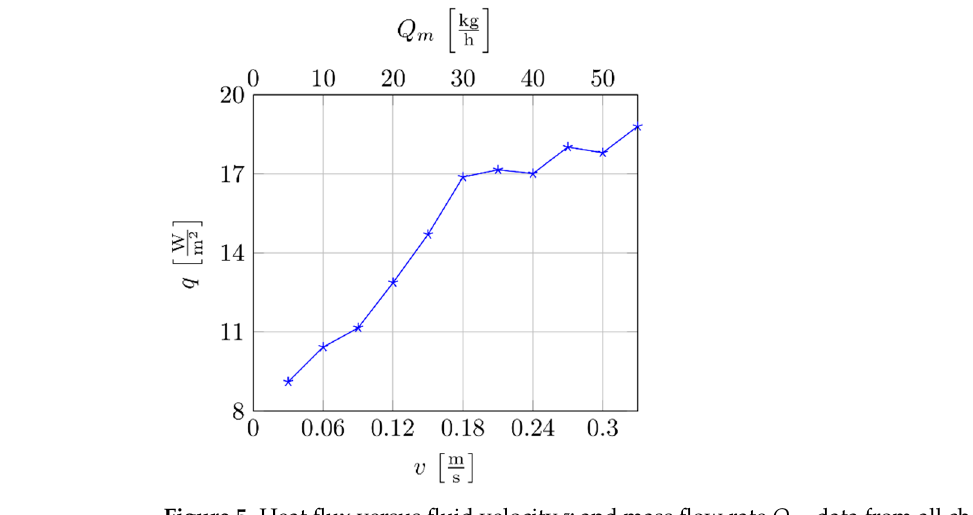
Figure 5. Heat flux versus fluid velocity v and mass flow rate Q m , data from all chosen experiments, corresponding to ONB points are marked on boiling curves, indicated by black arrows in Figure 4.